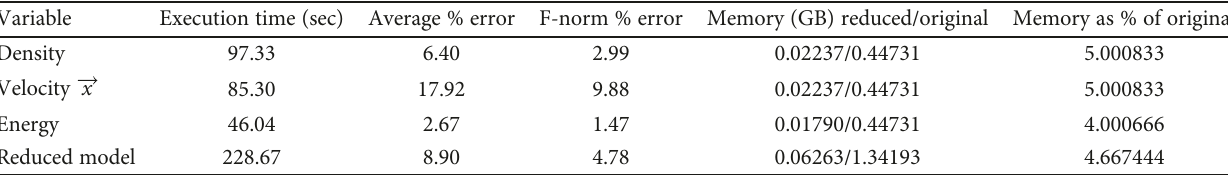
Table 19: One of the best reduced models based on results for the blade passage.